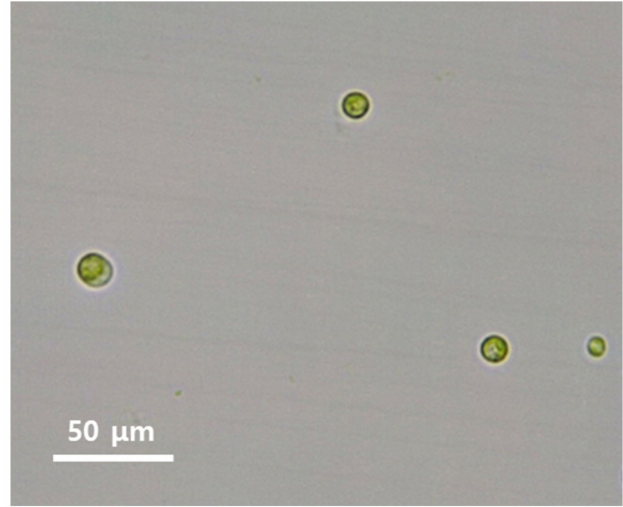
Figure 1. Morphology of Parachlorella sp. AA1 in U(VI) biosorption experiments. The shape of the strain AA1 cells was not disturbed after contact with the U(VI) containing solution.